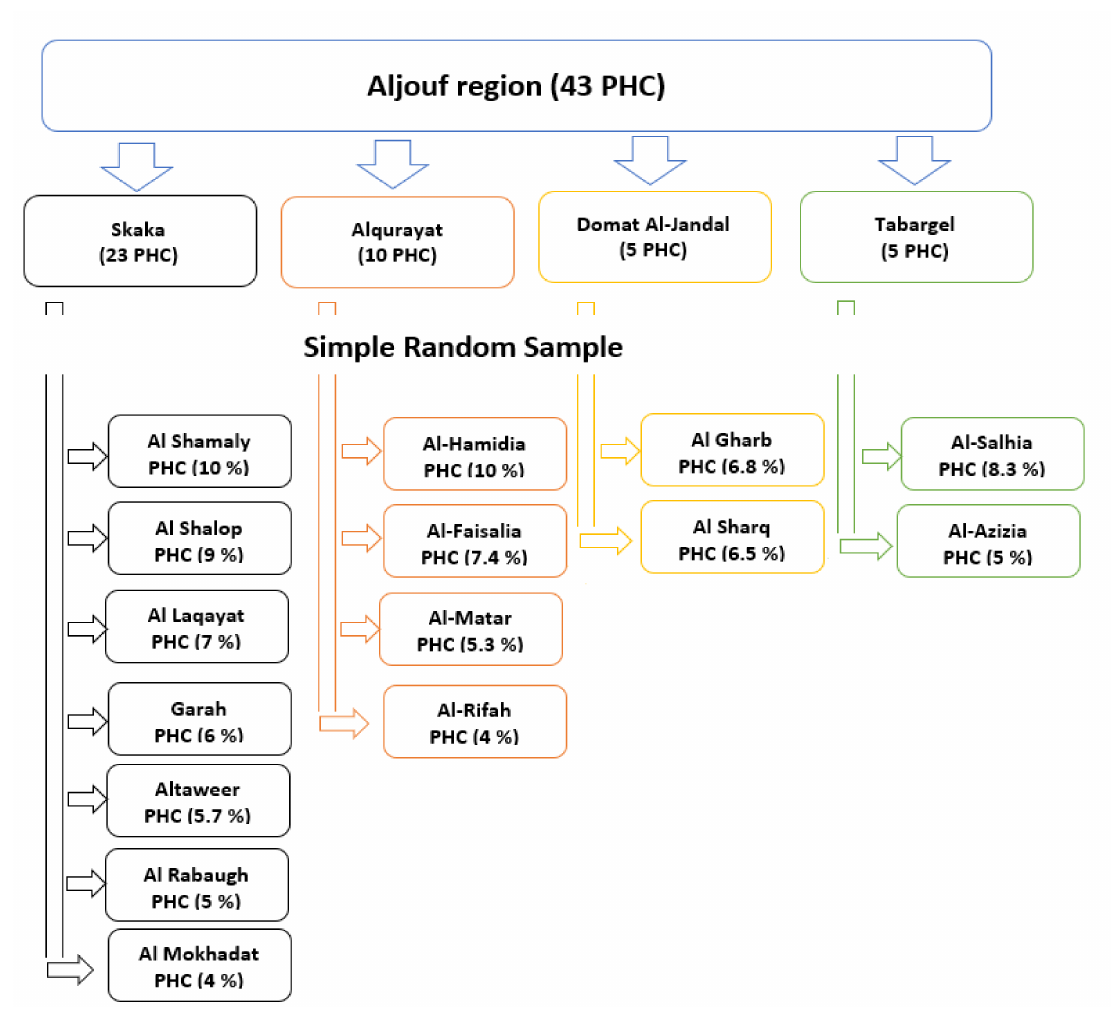
Figure 1. Schematic diagram of the sampling